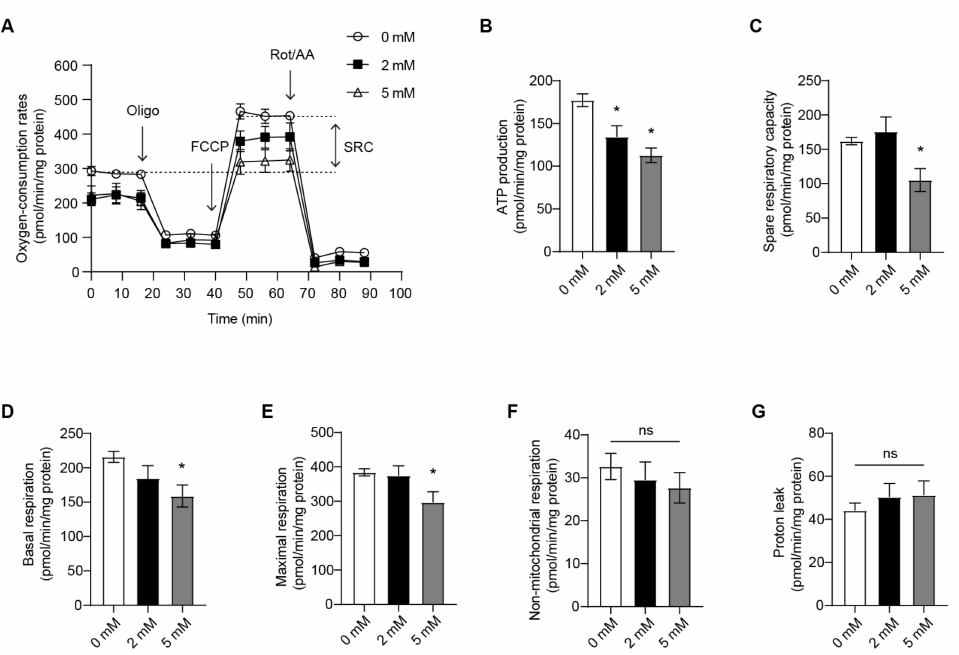
Figure 2. DM-AKG attenuated OXPHOS in RANKL-stimulated RAW264.7 cells. ( A ) Oxygen- consumption rates, ( B ) ATP production, ( C ) spare respiratory capacity (SRC), ( D ) basal respira- tion, ( E ) maximal respiration, ( F ) non-mitochondrial respiration, and ( G ) proton leak in RAW264.7 cells treated with RANKL and DM-AKG (0, 2 or 5 mM) for 12 h before treatment with oligomycin (oligo), carbonyl cyanide-p-trifluoromethoxyphenylhydrazone (FCCP), and rotenone plus antimycin A (Rot/AA) ( n = 4). All data were presented as means ± SEM. *, p < 0.05. Ns, no